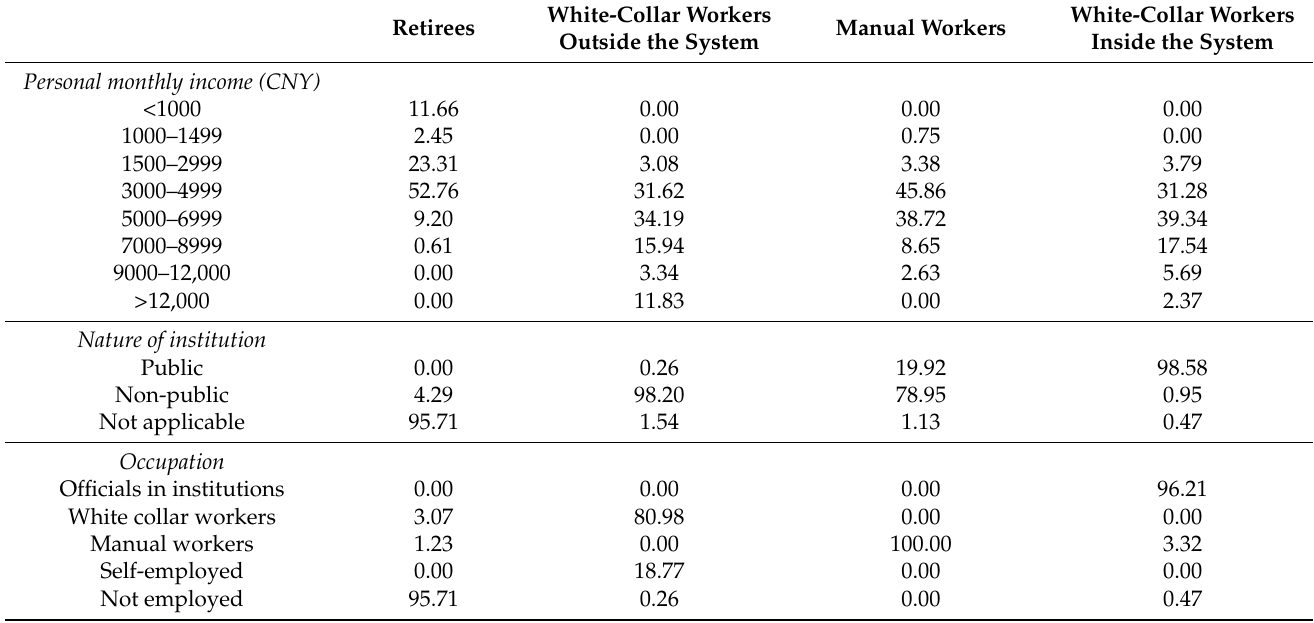
Table 1. Social-economic characteristics of the four